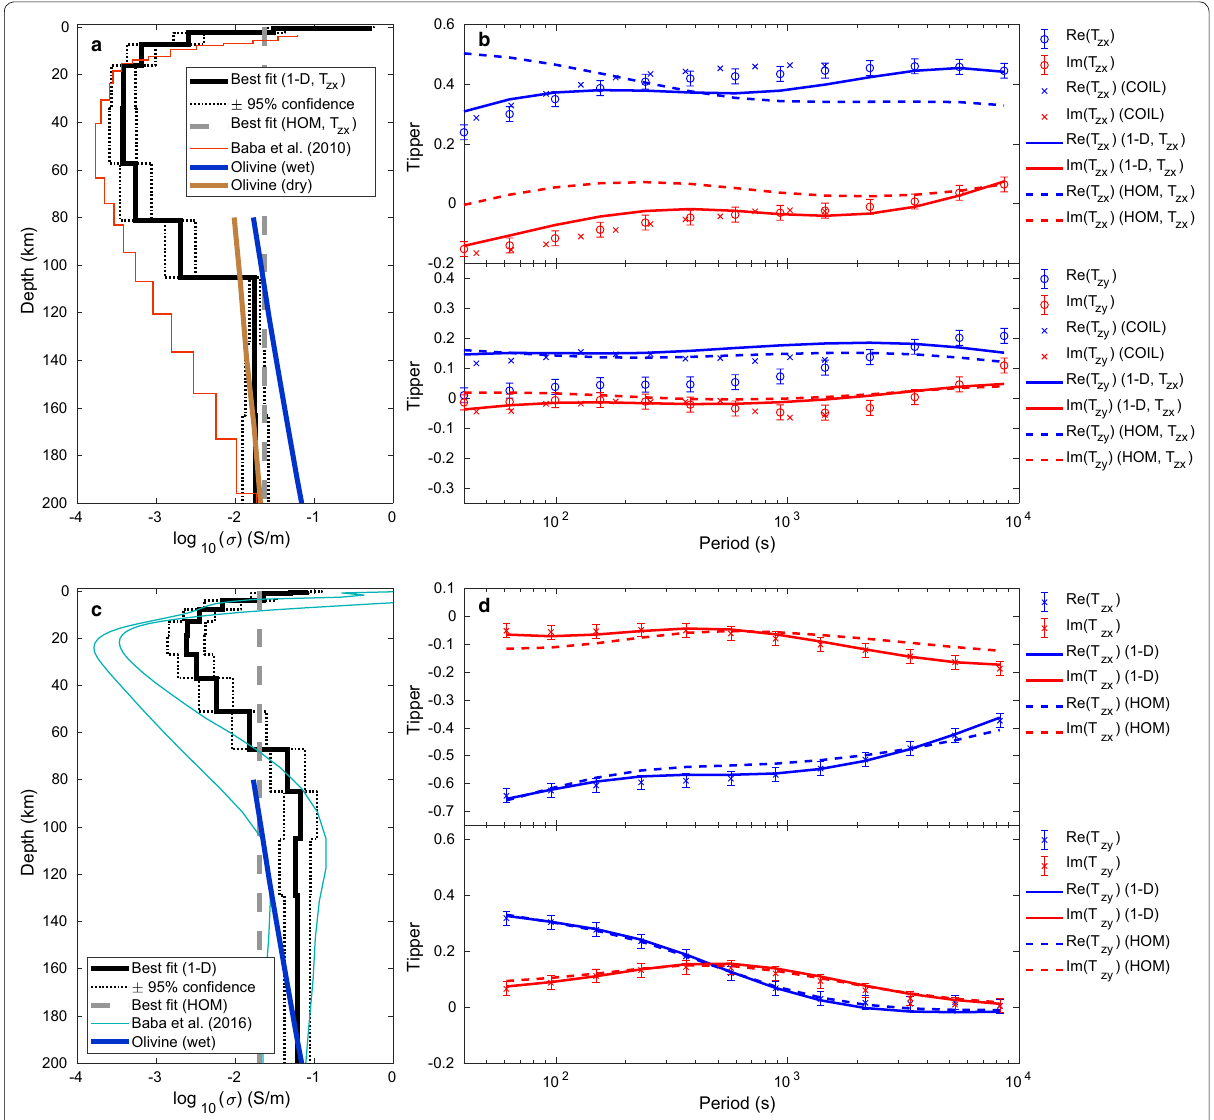
Fig. 4 Short title: 1-D conductivity profiles Detailed legend: Left column ( a c ): the best-fit conductivity profiles derived using tippers at the GAN + observatory ( a ) and the TDC observatory ( c ) are shown by black solid lines along with 95 % confidence intervals (black dashed lines). For reference, the conductivity profiles for old Pacific lithosphere (red line, Baba et al. 2010), for Tristan da Cunha (turqouise line, Baba et al. 2016), and hydrous and dry olivine (blue and brown lines, Katsura and Yoshino 2015) are shown. Additionally, best-fit homogeneous Earth models are shown by dashed gray lines. Right column ( b d ): the observed tippers are indicated by circles, the tippers predicted from the 1-D models are indicated by solid lines, + and the tippers predicted from the homogeneous Earth models are indicated by dashed lines. Additionally, induction coil data for GAN are shown by